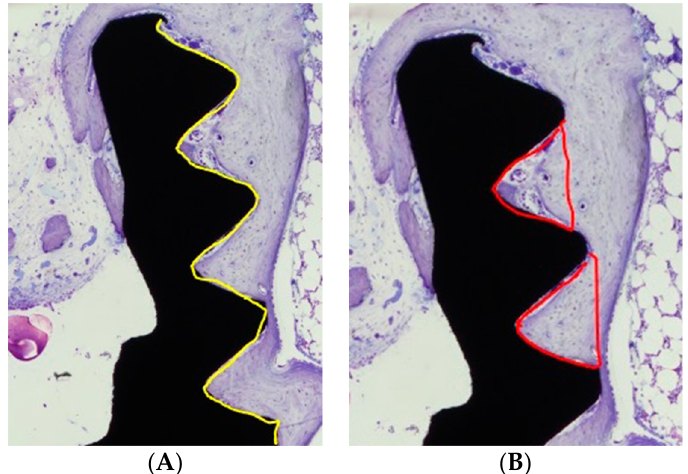
Figure 2. ( A ) Micro-implant subjected to histomorphometric analysis. The yellow line illustrates the region of interest for the BIC (bone-to-implant-contact) analysis (toluidine blue stain, × 10). ( B ) Micro- implant subjected to histomorphometric analysis. The marked red areas indicate the region of interest for BA (Bone Area) analysis (toluidine blue stain, ×